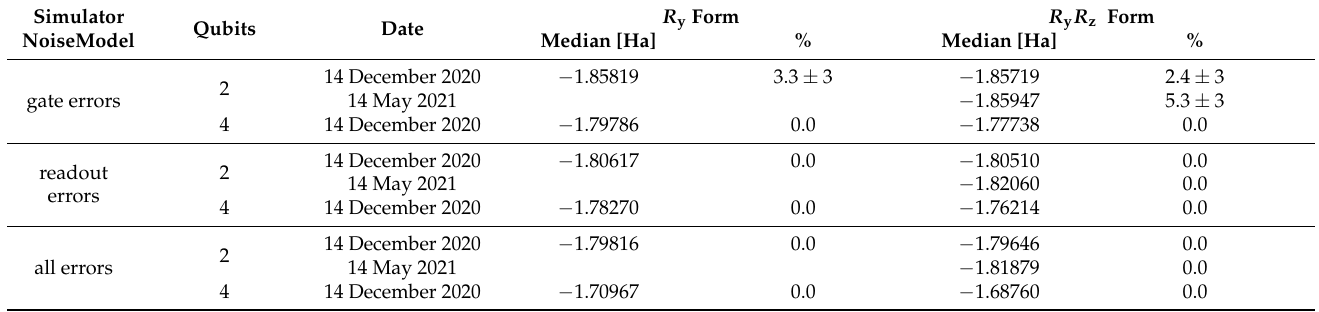
Table A5. A comparison of results from different dates and different noise models built from a real quantum processor, ibmq_santiago. The number of shots was set to 4096. The calculations were performed using both the R y R z and R y variational forms. The classical optimization method SPSA was used, for 2-qubit system the maxiter was unrestricted and for 4-qubit system, the maxiter was set to 400. The last column represents the percentage of the runs that ended within chemical accuracy ( − 1.86712 ± 0.0015 Ha) of the optimum. The error margin of 3 percent was estimated based on the standard deviation of 1000 identically distributed trials. These data are the basis for Figures 6 and 7.